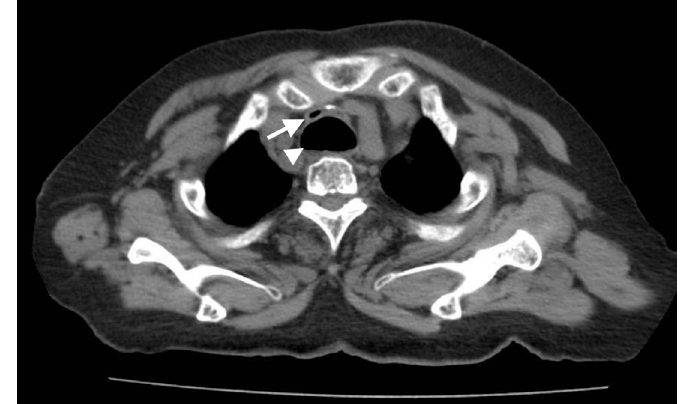
Image 1. Compressed trachea (arrow) by dilated esophagus (arrowhead) at the level of the sternoclavicular joint.